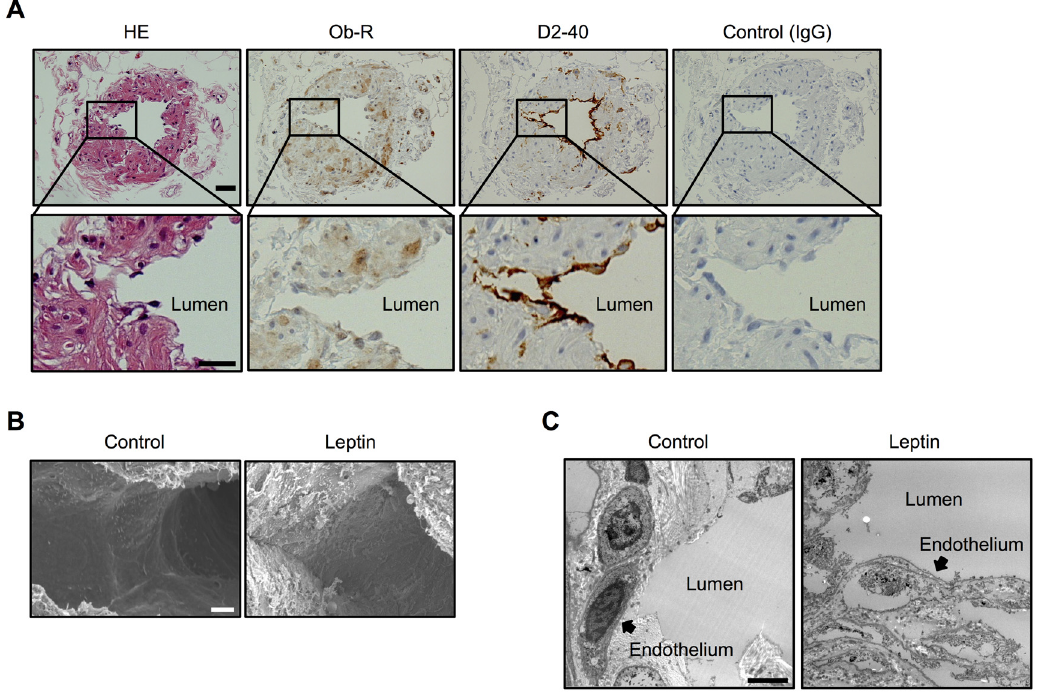
human lymphatic duct were stained with hematoxylin and eosin (HE). Scale bar: 5 μ m. Scanning electron microscopy ( B ) and transmission electron microscopy ( C ) images demonstrating morphological changes of the human lymphatic duct exposed to a high dose of leptin for three days. Scale bar: 100 μ m ( B ), 2 μ m ( C ). Images ( B and C) are representative images obtained from at least 4 different lymphatic duct specimens treated with/without leptin.